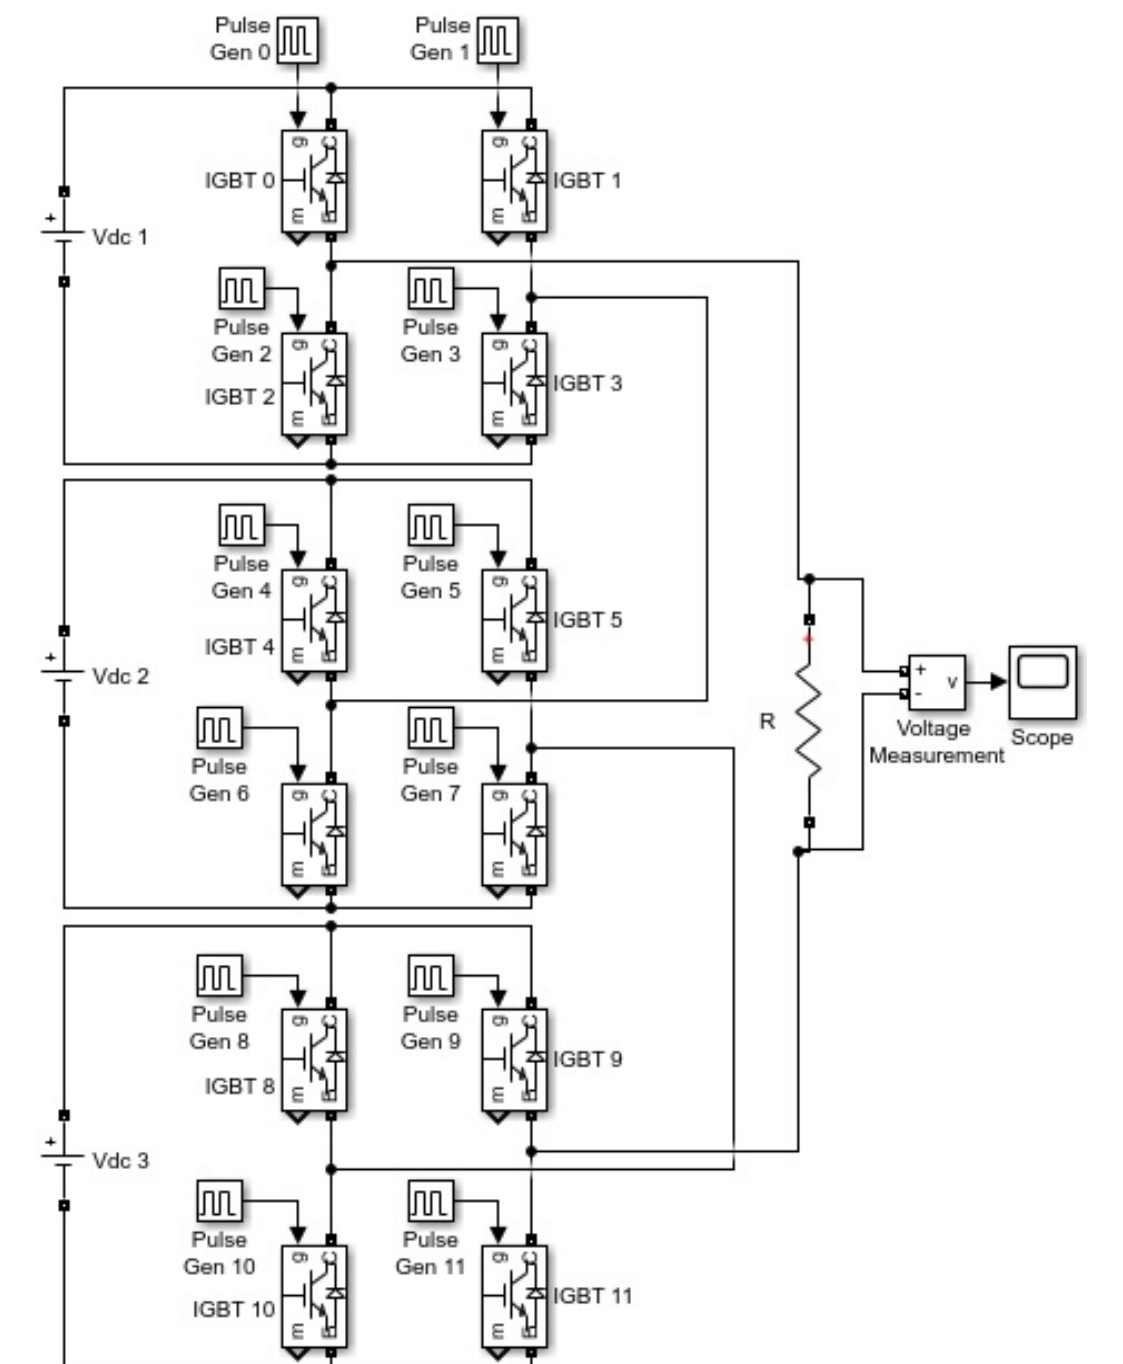
Figure 5. Seven-level inverter circuit.